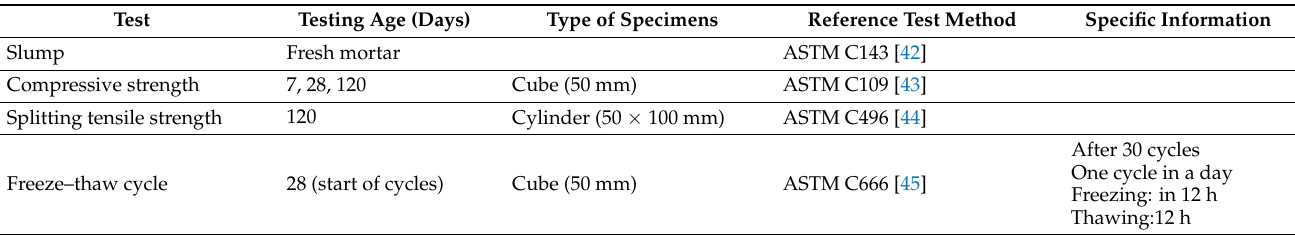
Table 3. Details of tests performed on fresh and hardened specimens. Test